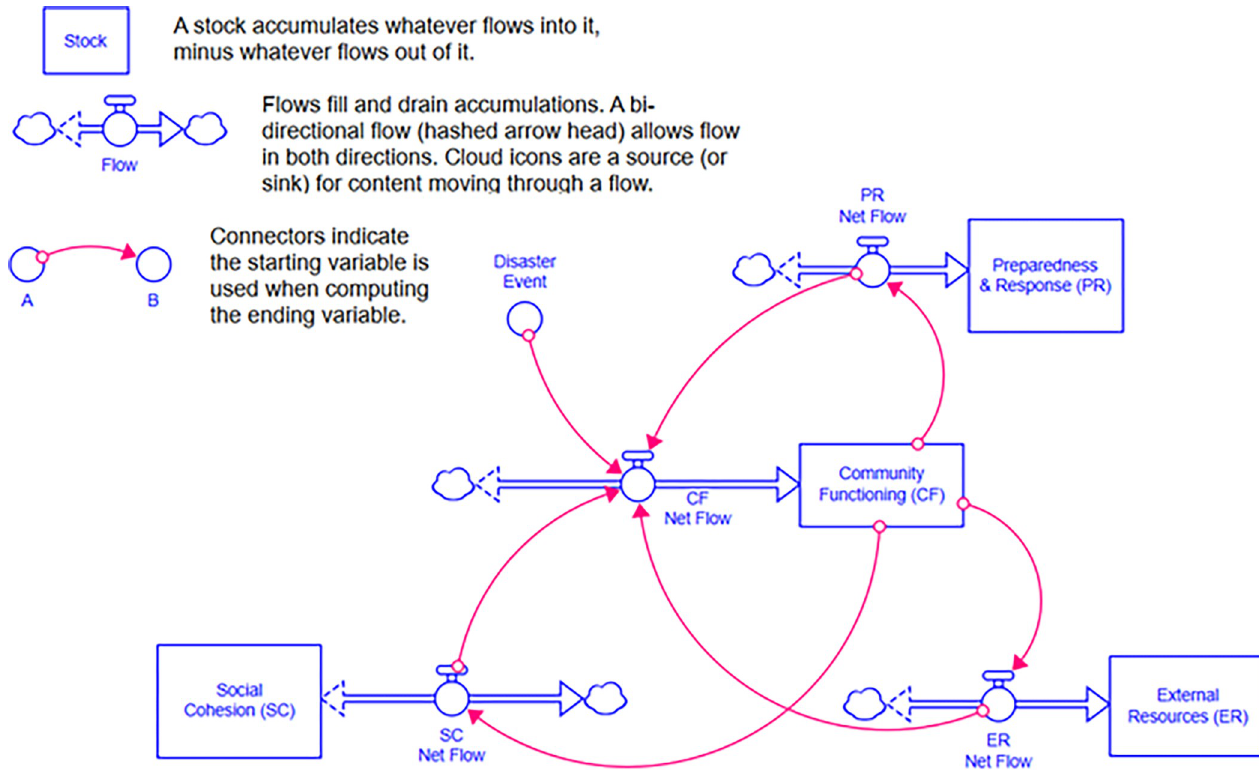
Fig 3. Conceptual system dynamics model of key components of community functioning (CF) after a disaster